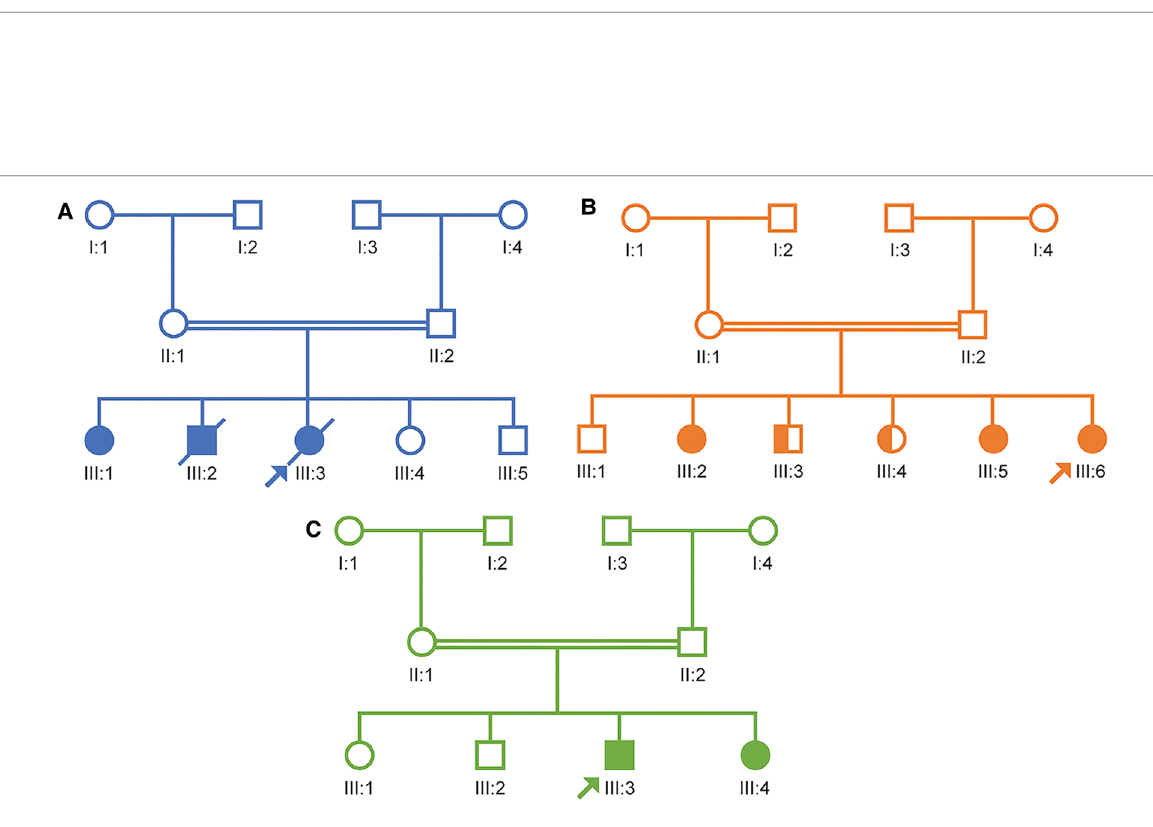
FIGURE 2 Pedigree diagrams for the three case study patients. ( A ) Case study 1. ( B ) Case study 2. ( C ) Case study